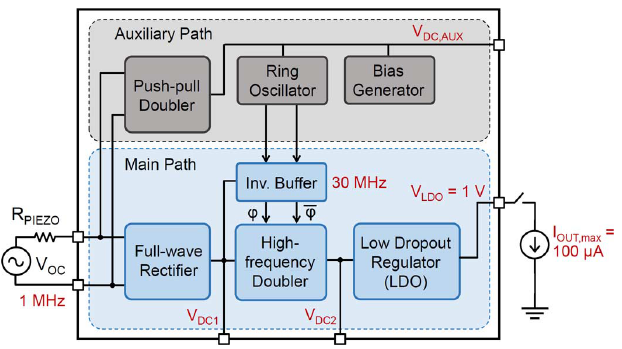
Fig. 5. Hybrid two-path architecture of the power recovery circuit. Figure 14. Hybrid two-path architecture of the power recovery circuit proposed in [44]. Reproduced with permission from J. Chartad, IEEE Journal of Solid-State Circuits; published by IEEE,